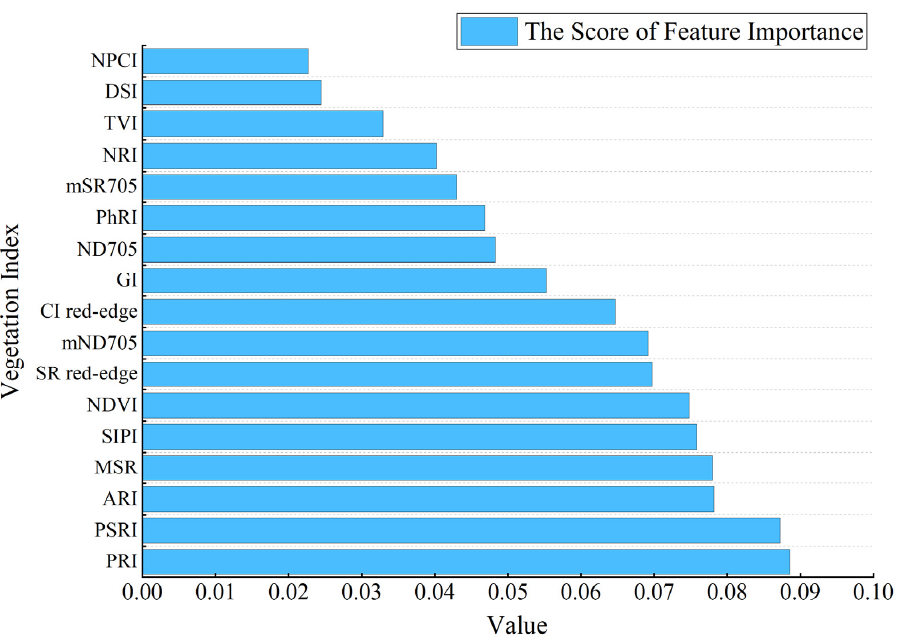
Figure 7. Effect of the number of features on the AUC value of the model.